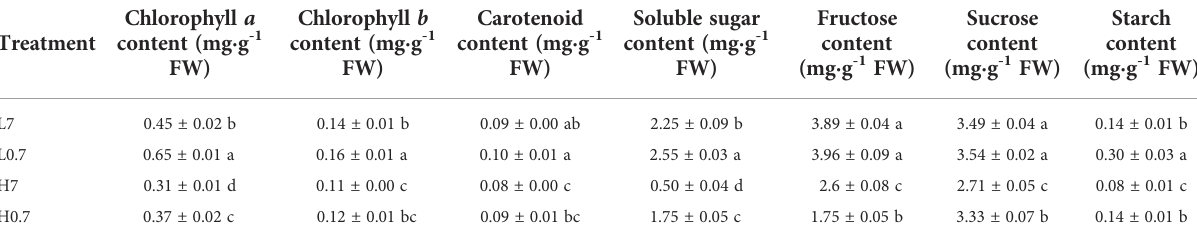
TABLE 2 Effect of R/FR ratio on photosynthetic pigment and carbohydrate contents in cucumber leaves under salt stress.